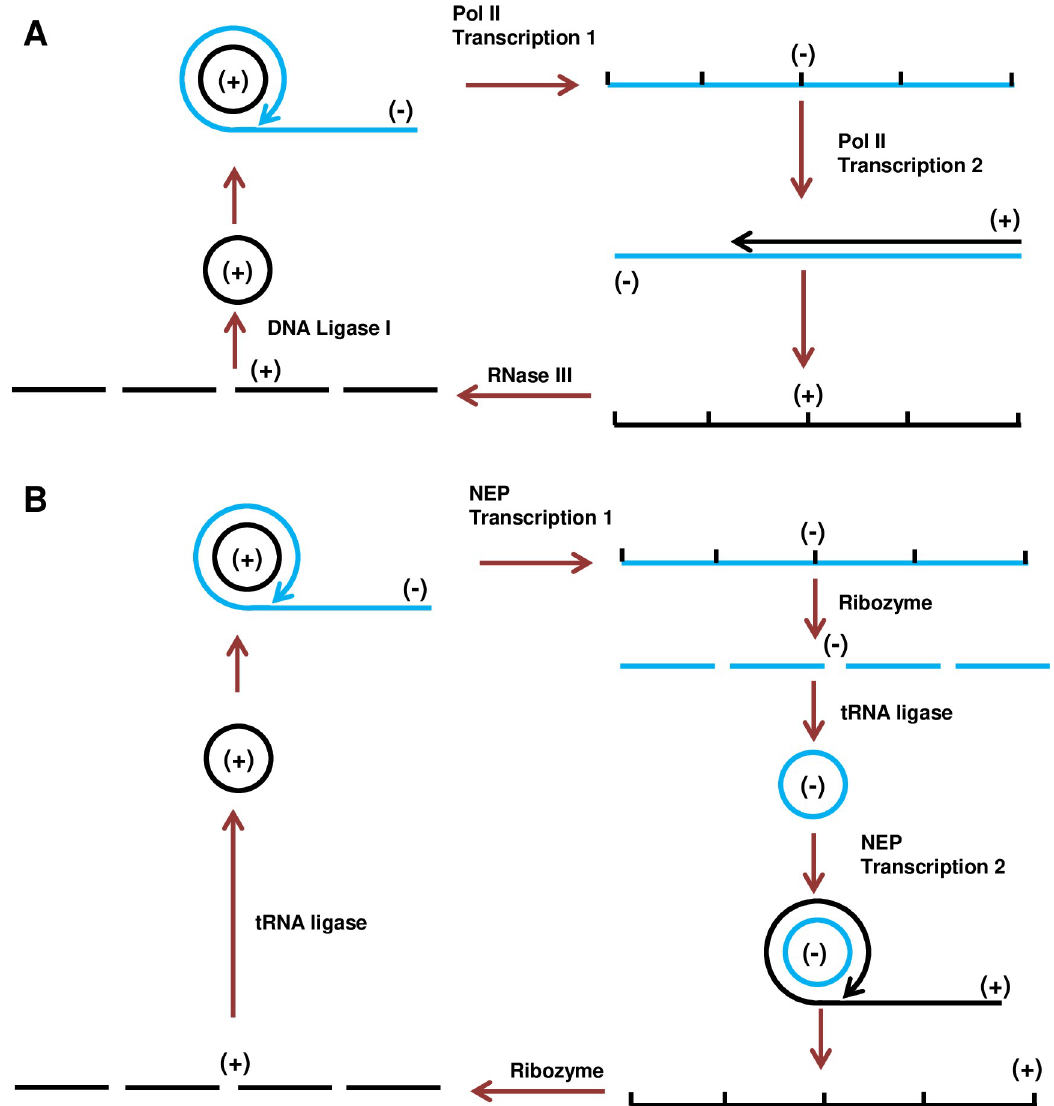
Fig 1. Rolling cycle replication of viroids. (A) Asymmetric rolling circle replication in the Pospiviroidae occurs in the nucleus. Circular (+)-strand genomic RNA is transcribed by DNA-dependent RNA polymerase II (Pol II) to produce linear (-)-strand concatemers, which serve as template for Pol II-catalyzed synthesis of linear (+)-strand concatemers. These are cleaved to unit- length monomers by RNase III and circularized by DNA Ligase I. (B) Symmetric rolling circle replication in the Avsunviroidae occurs in the chloroplast. Circular (+)-strand genomic RNA is transcribed by nuclear-encoded chloroplast RNA polymerase (NEP) to generate linear (-)-strand concatemers, which are cleaved to monomers by an encoded hammerhead ribozyme and circularized by a tRNA ligase. Circular (-)-strand monomers serve as template for NEP-catalyzed synthesis of linear (+)-strand concatemers, followed by a second ribozyme cleavage to form monomers, which are circularized by tRNA ligase.